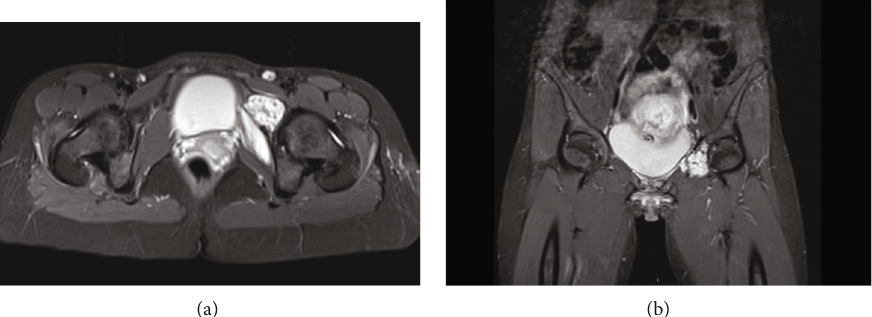
Figure 1: Axial (a) and coronal (b) T2 STIR weighted views on initial MRI of the pelvis showing a chondrogenic lesion of the left iliopubic ramus extending in the anterior acetabular wall.